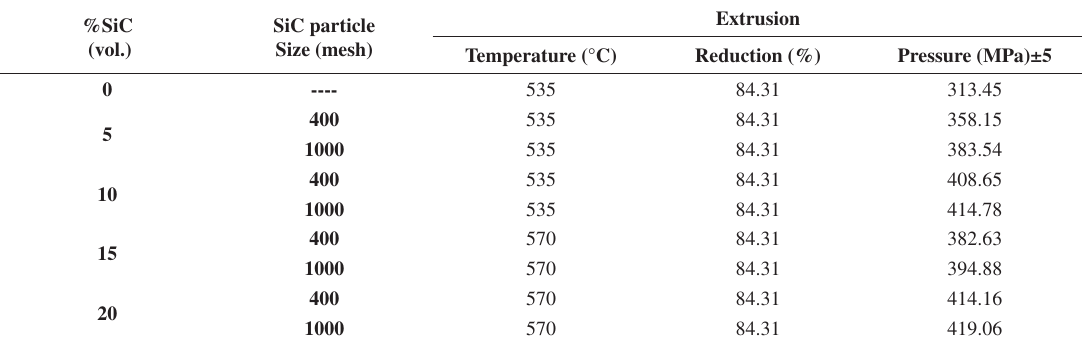
Table 1. Required pressure for hot extruding at different processing condition. %SiC (vol.)